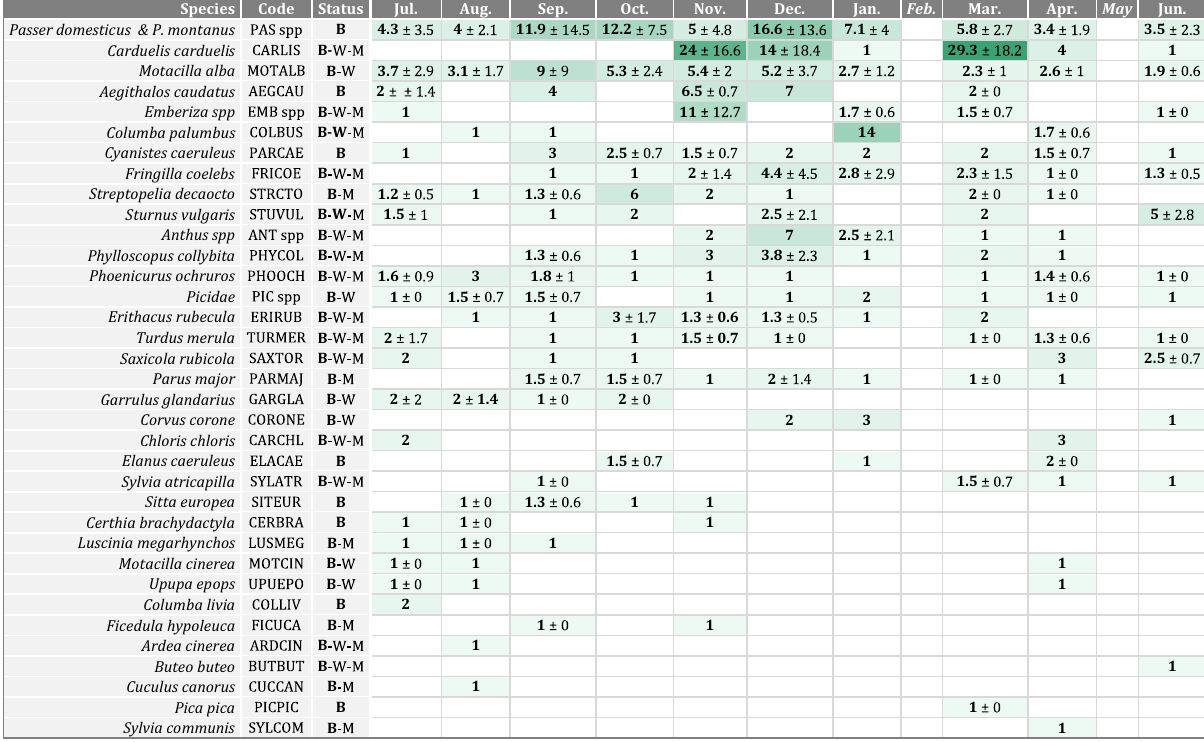
sions. The minimal number of individuals (i.e. maximum observed at the same time) varied with species, and ranged up to 44 individuals for European Goldfinch ( Carduelis carduelis , CARLIS). Resulting monthly means of minimum species group sizes ranged from 1 to 29.3, with a few increases in the number of gregarious species (Table 1). The monthly number of wild bird species ranged from 14 to 20 (Fig. 2). The diversity indices of Simpson (D) and Shannon (H) and the evenness index of Piélou (J) (Fig. 2) showed similar patterns, with highest values in April (D = 15.4, H = 17.4, J = 0.95) and July (D = 13.8, H = 15.8, J = 0.95), then dropping during fall and winter down to the lowest values in March (D = 4.1, H = 8.3, J = 0.73). Using data of observations in presence of ducks, the direct environment of individual birds were analysed to quantify behaviours allowing potential direct or indirect interactions between wild birds and domestic ducks. Nine of the 23 species (8 of the 22 groups of species) observed in the presence of domestic ducks were recorded at least once at less than one meter from ducks (Fig. 3a). The frequency of these direct contacts represented 131 observations in the 953 total observations with presence of ducks (13.7%), implying a cumulative count of 294 individuals out of the 2446 cumulative individual birds. The vast majority of direct contacts implied MOTALB with 106 observations of 245 individuals, accounting for 83% of all birds showing direct contact with ducks and for 23% of all interactions with ducks shown by the species (Fig. 3a). This was followed by PAS spp, with 14 obser- vations of 32 individuals, accounting for 11% of birds in direct contact with ducks and for 3% of interactions with ducks by the species (Fig. 3a). This was followed by Turdus merula TURMER and Garrulus glandarius GARGLA with each one 5 individuals (each one accounting for 1.7% of birds in direct contact, and respectively 19% and 36% of interactions by each species), followed by Aegithalos caudatus AEGCAU (3 individuals, 1.0% of birds in direct contact and 100% of interactions by the species), Streptopelia decaocto STRCTO (2 individuals, 0.7% of birds in direct contact and 40% of interactions by the species), and Sturnus vulgaris STUVUL and Phoenicurus ochruros PHOOCH (each one with 1 individual, 0.3% of birds in direct contact, and respectively 50% and 4% of interactions by each species) (Fig. 3a). Recordings of bird behaviour and locations on foraging areas revealed situations of proximity between wild birds and duck aggregation areas such as feeders, drinkers or inside duck premises (Fig. 3b). These observations (41 out of 953, implying a cumulative count of 70 individuals) implied only 3 species: MOTALB (25 observations of 32 individuals), PAS spp (15 observations of 37 individuals) and STRCTO (1 observation of one individual on a drinker). Only MOTALB and PAS spp were observed flying into